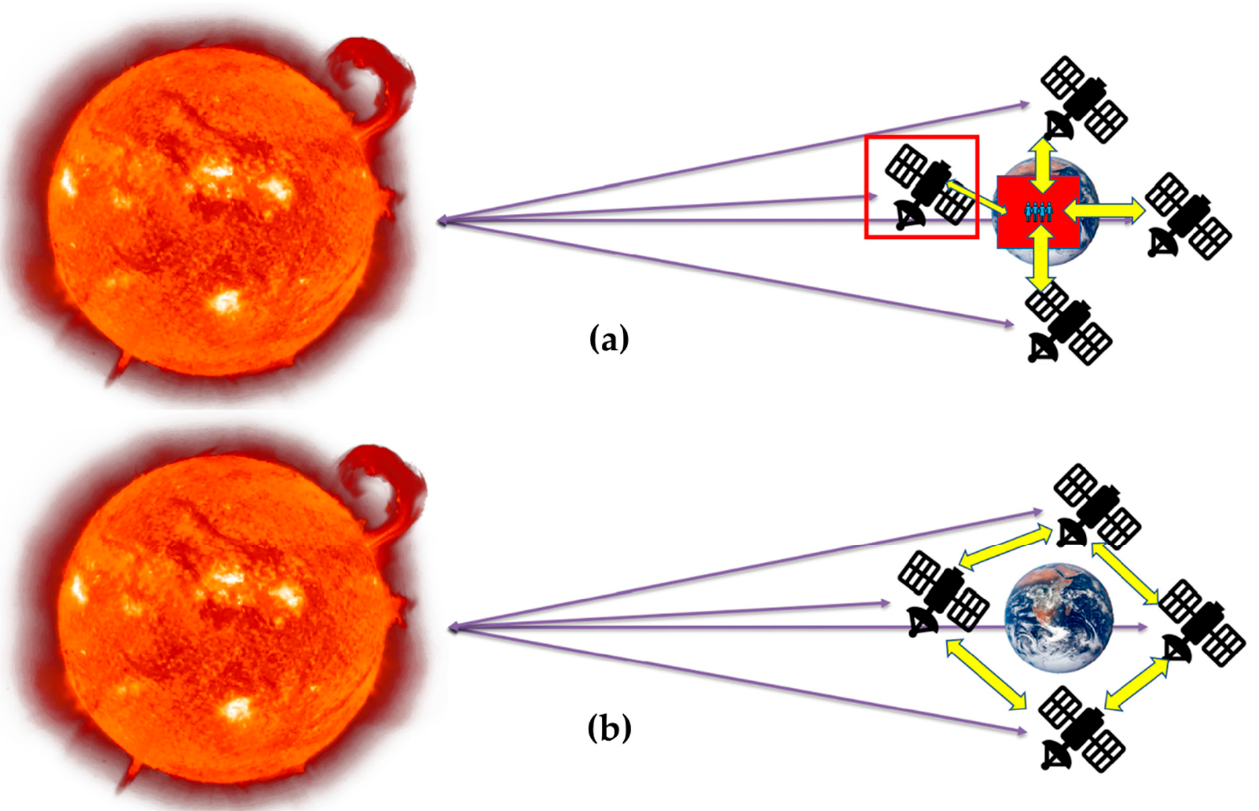
Figure 2. ( a ) Current state-of-the-art DSS operations; ( b ) DSS operation with ISL, i.e., iDSS. Adapted from [3].